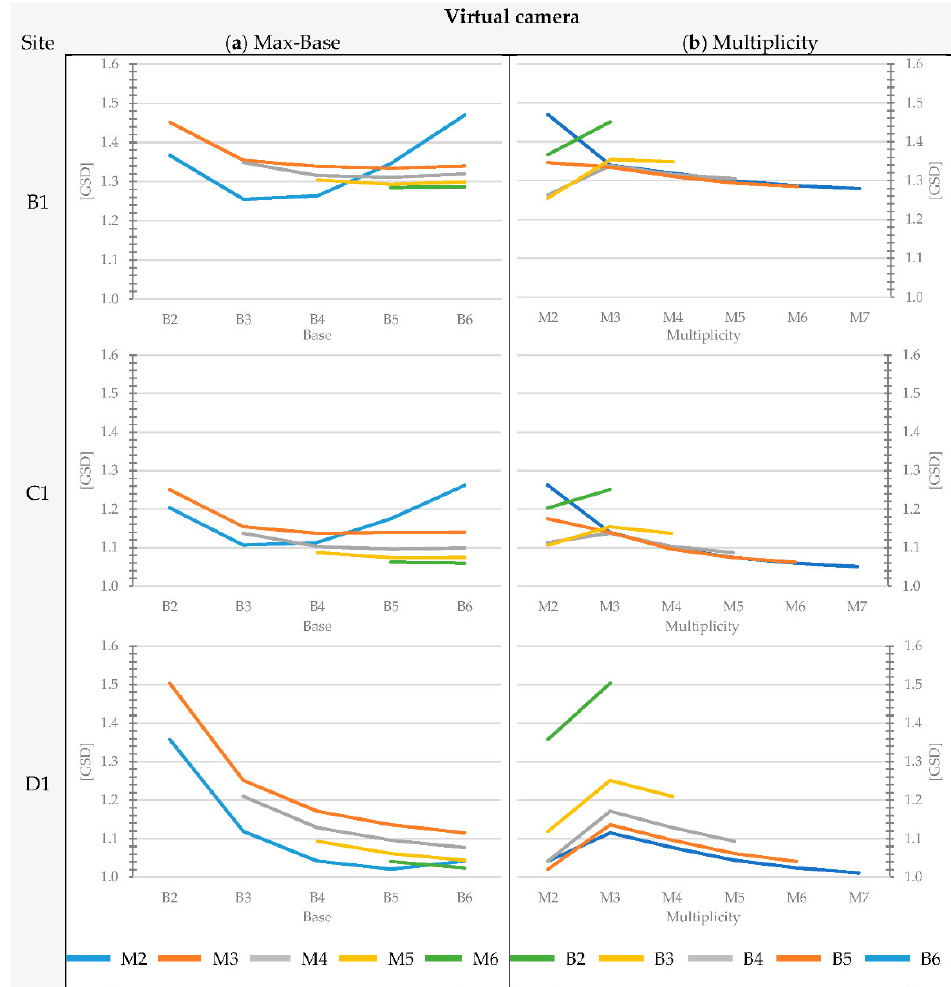
Figure 6. Graphs showing the standard deviation of the elevation disparity between DEMs and the reference model for Sites B1, C1 and D1 as a function of ( a ) max ‐ base variability and ( b ) multiplicity. (Value of standard deviation for combinations B1 ‐ M2: Site B1 = 1.79, Site C1 = 1.68 and Site D1 = 2.44 times the GSD).